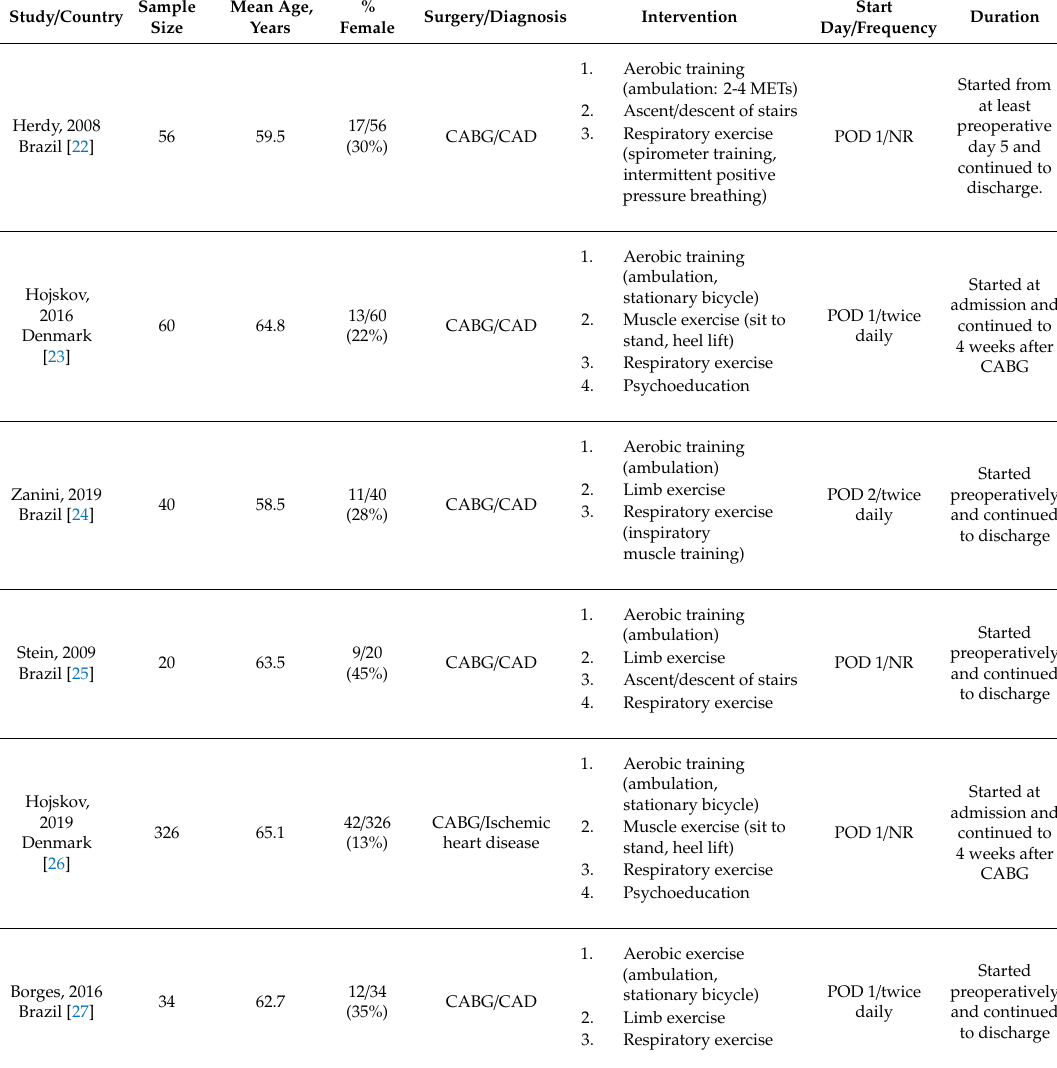
Table 1. Summary of included